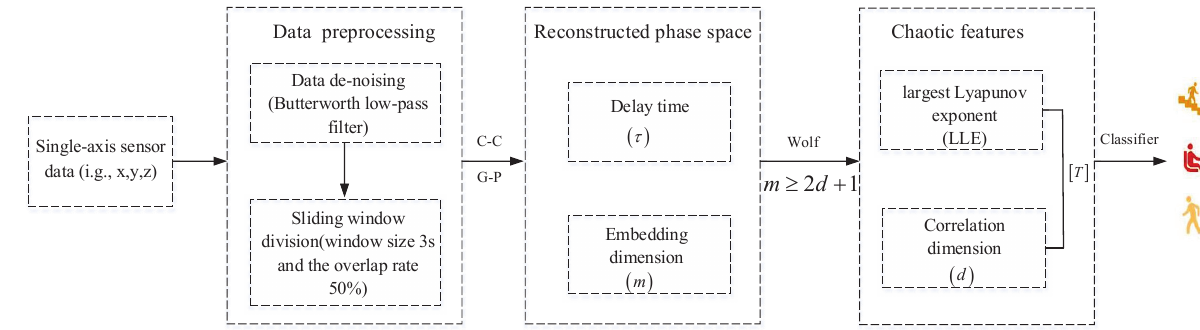
Figure 2. A dynamical chaotic features model-based for Human activity recognition (HAR)